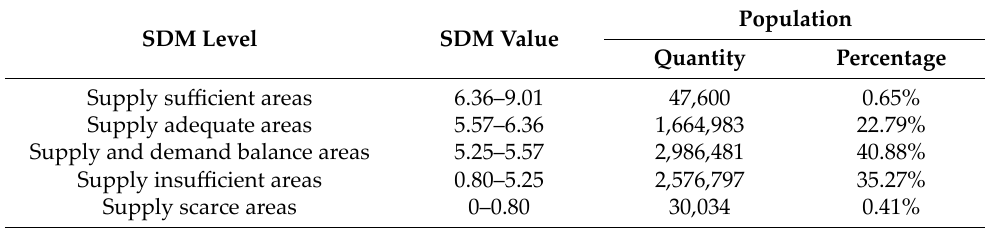
Table 5. Hierarchical statistics of SDM of public natural health resources in central Tianjin.